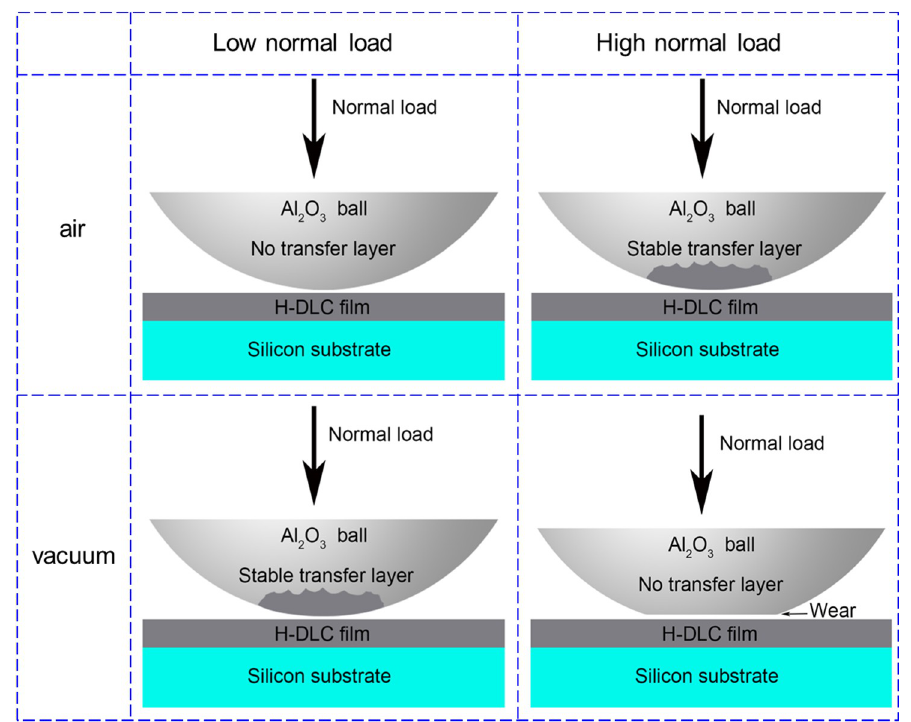
Figure 8. Schematics showing formation and stability of transfer layer on counterface after sliding H-DLC films at different load conditions in humid air and vacuum.